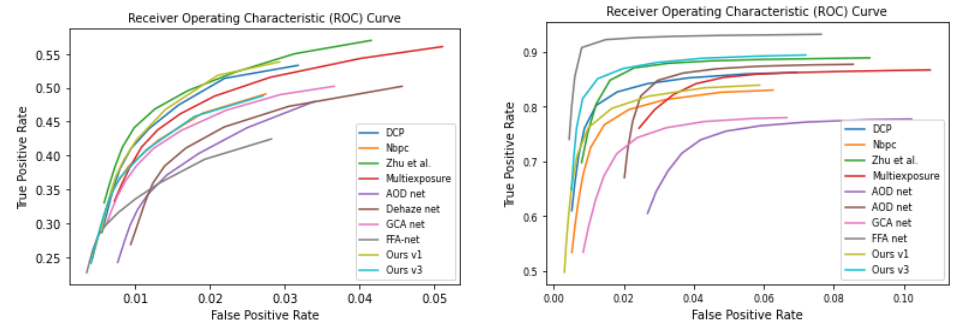
Figure 13. ROC curves comparison for different algorithms. ( Left ): ROC curves obtained from fifty images of the FRIDA dataset. ( Right ): ROC curve from fifty images of the SOTS dataset. The max threshold of the Canny filter is set to 180. The legend Multiexposure corresponds to Zhu et al.’s [22]